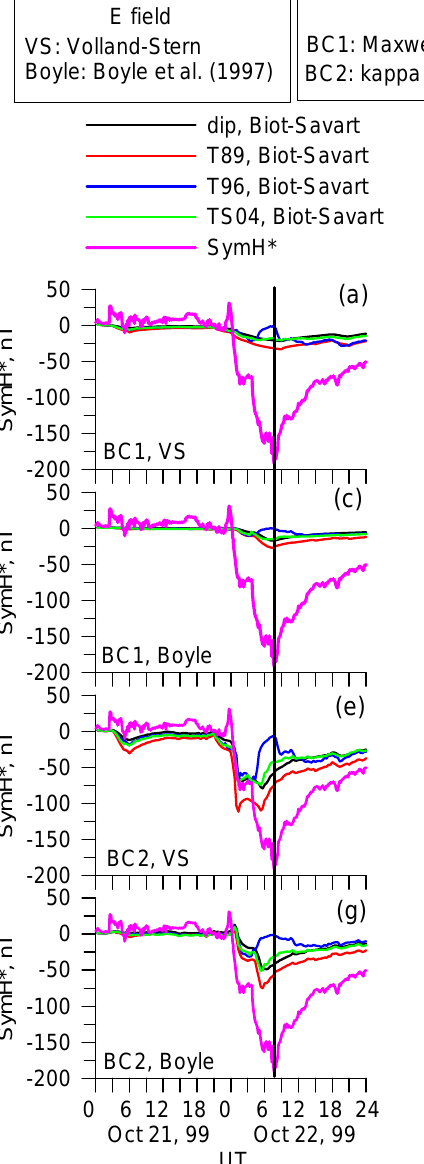
Volland-Stern (open diamonds) and Boyle (black diamonds) electric fields as dependent on the four magnetic field rep- resentations (dipole, T89, T96, and TS04). Figures in the left column were obtained by using the Biot-Savart law and figures in the right column by using the DPS relation for SymH* calculations. Purple horizontal lines mark the ob- served SymH* minimum value of − 100 nT.